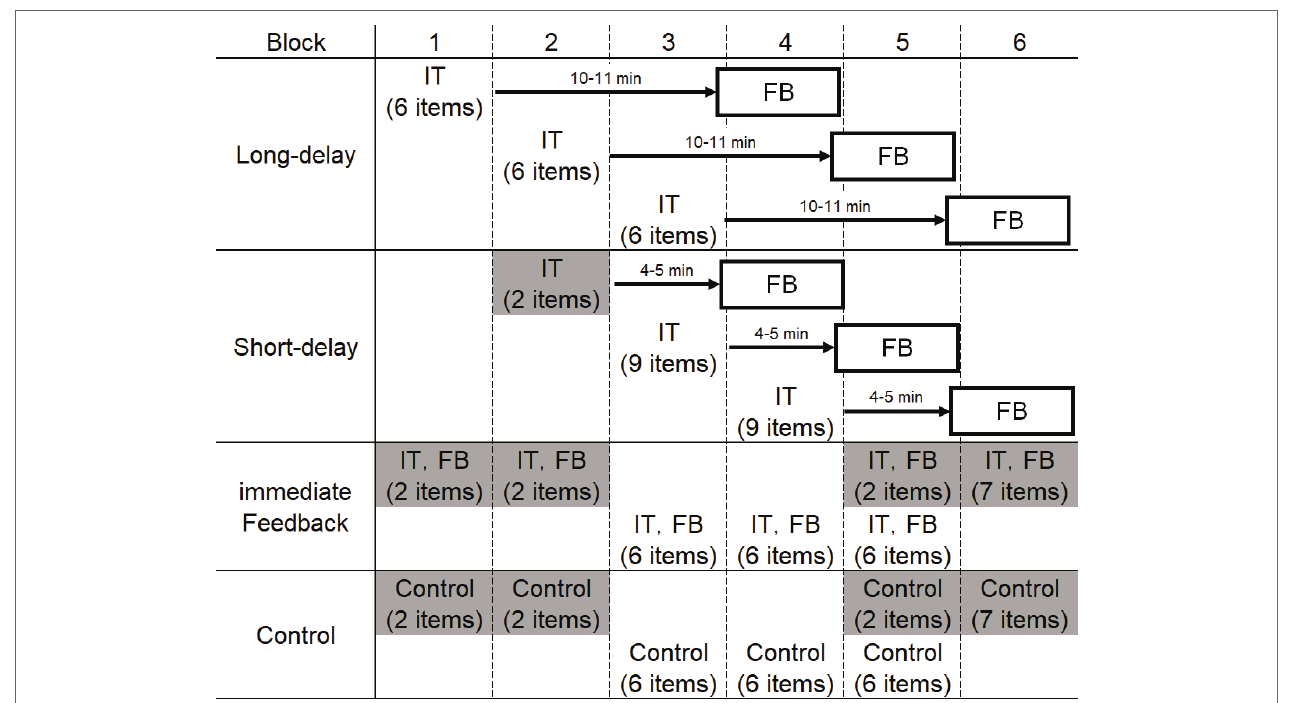
FIGURE 5 | Stimulus presentation flow for each condition in Experiment 2. Stimuli for each condition were allocated to Blocks 1–6. In the long-delay and short-delay conditions, feedback was given after intervals of 10–11 and 4–5 min, respectively. We set filler trials (grayed-out cells) for the following reasons: (1) in order to ensure the delay time before feedback presentation was for long- and short-delay conditions (10–11 or 4–5 min) and (2) participants were not made aware that the program was divided into blocks. IT indicates “initial test” and FB indicates